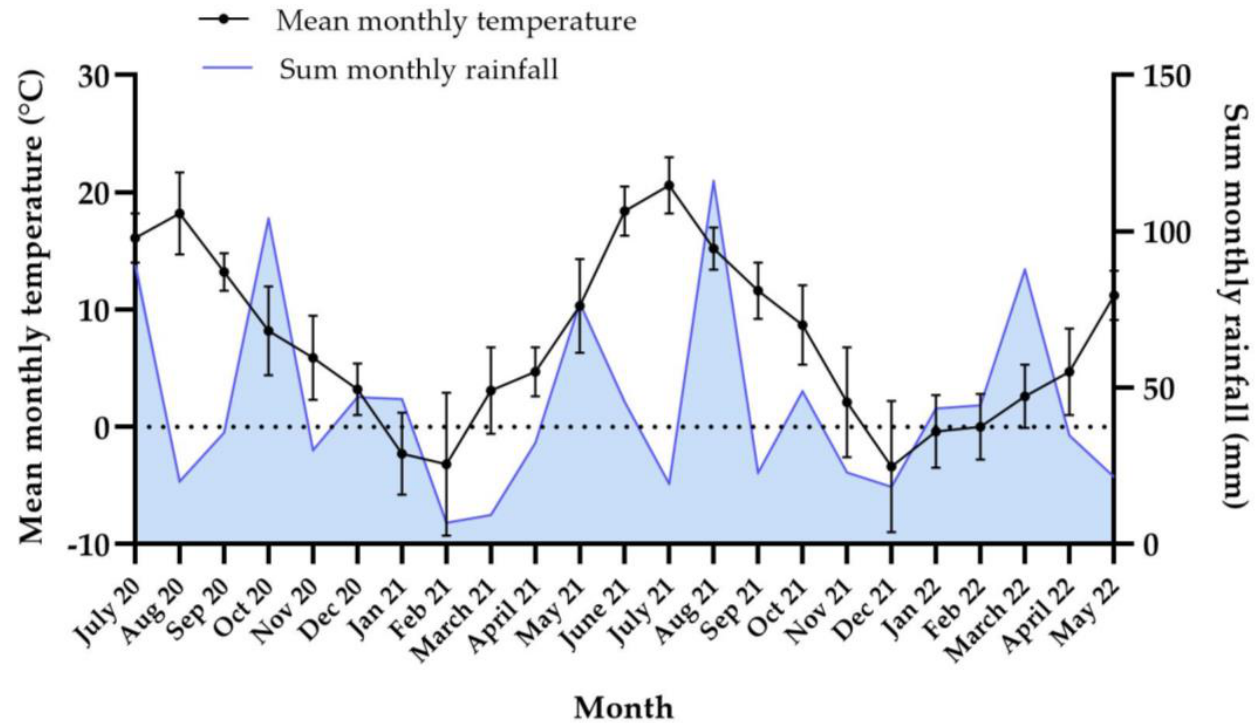
Figure 10. Graph showing mean (±SD) monthly temperature (°C) and total monthly rainfall (mm) during the overwintering study. The dotted gridline marks 0 °C.